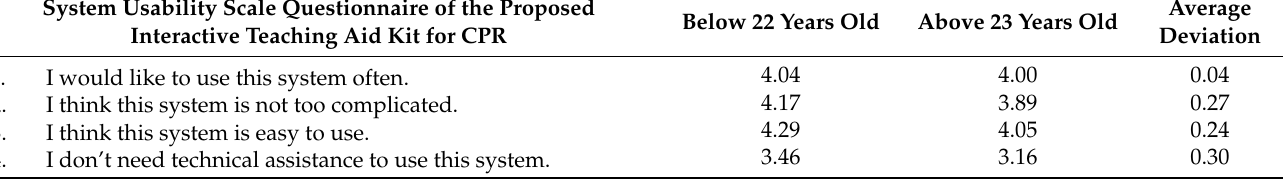
Table 4. The analysis of the questionnaire in users’